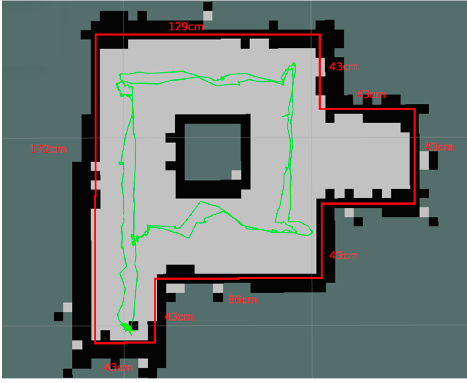
Figure 5. Evaluation of the robot’s ability to create maps.